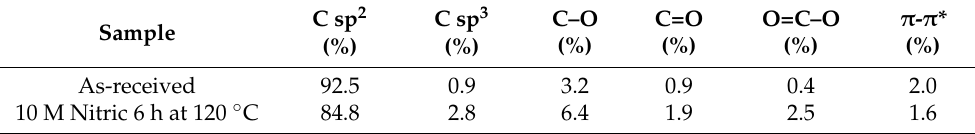
Table 7. Relative percentage of carbon states determined by deconvolution of the XPS C1s region.